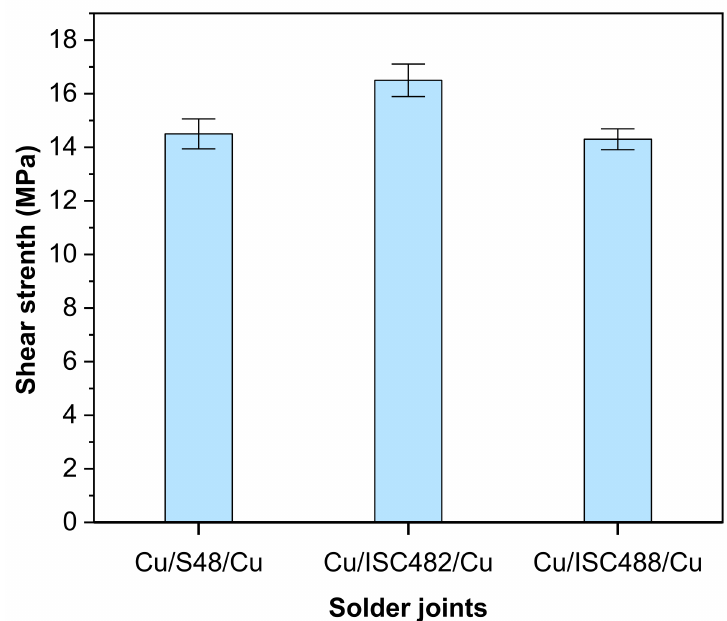
Figure 7. Shear strengths of the alloy joints.